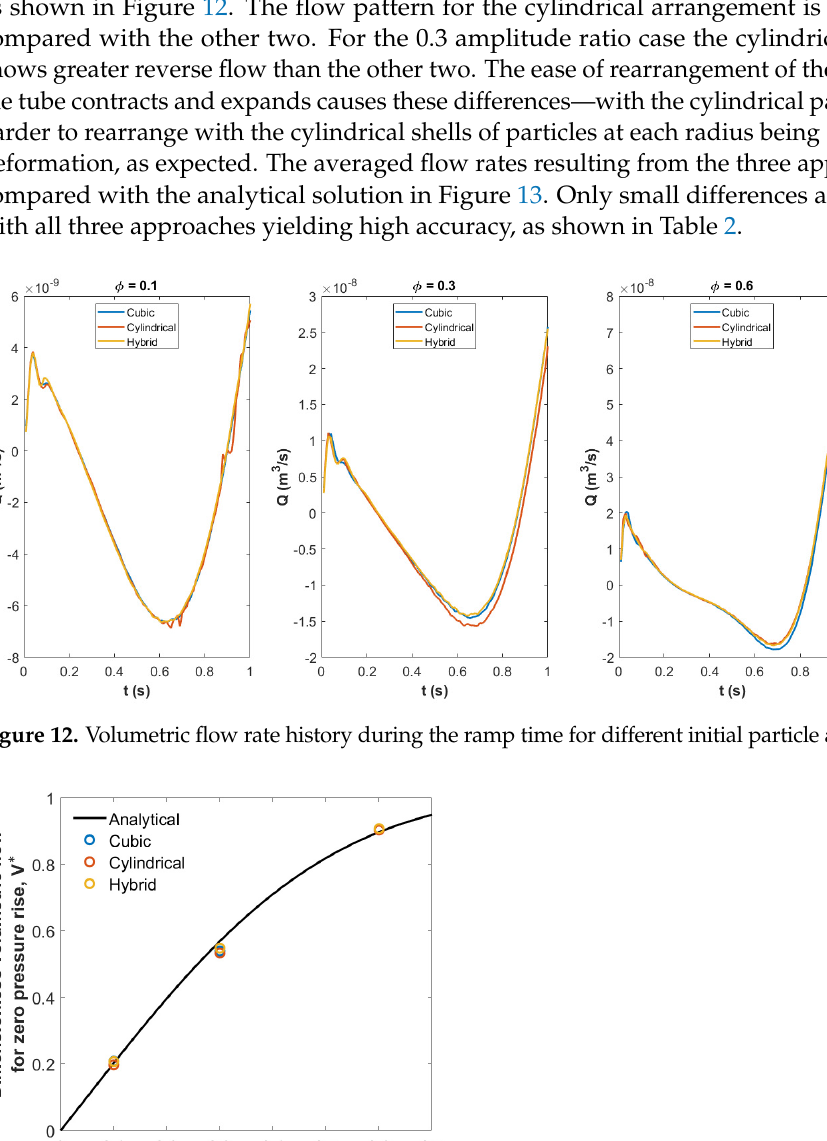
Figure 13. Effect of initial particle arrangement in the SPH model on the dimensionless volumetric